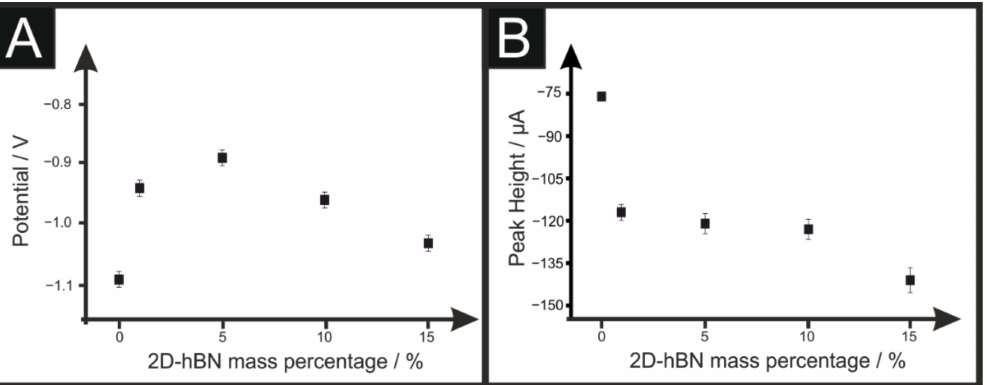
Figure 3. Analysis of voltammograms obtained in an oxygen saturated 0.1 M H 2 SO 4 solution in the form of a plot of oxygen reduction peak potential vs. incorporated 2D-hBN % ( A ), peak potential vs. mass of pristine 2D-hBN/SPEs and ( B ) peak current vs. mass of pristine 2D-hBN/SPEs, recorded in oxygen saturated 0.1 M H 2 SO 4 . Scan rate: 100 mV s − 1 (vs. SCE); n =